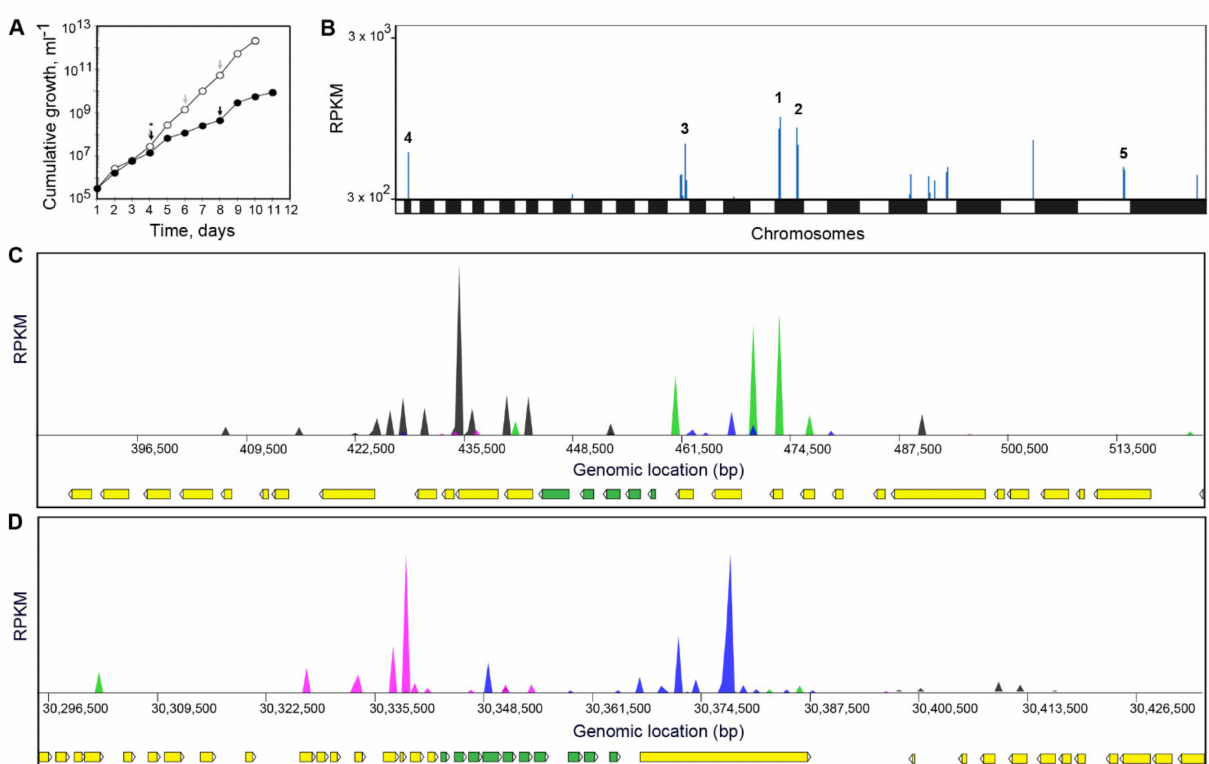
Figure 3. Screen of L. donovani cosmid library with DNDI-6148. ( A ) Cumulative growth of the L. donovani library in the presence (black circles) or absence (white circle) of DNDI-6148. Arrows indicate where the treated and untreated libraries were passaged. ( B ) Genome-wide map indicating cosmid library hits from the screening of DNDI-6148. The top five hits based on total reads are indicated. (C & D) Focus on two “hits” on chromosome 2 ( C ) and 35 ( D ), respectively. The genes flanked by a majority of barcodes, and therefore most likely to be conferring resistance, are indicated in green, while other genes are indicated in yellow. Possible genes (following a rationalization based on the location of barcodes) are shown as green bars, other genes as yellow bars. The blue/pink and black/green peaks indicate independent cosmid inserts in different